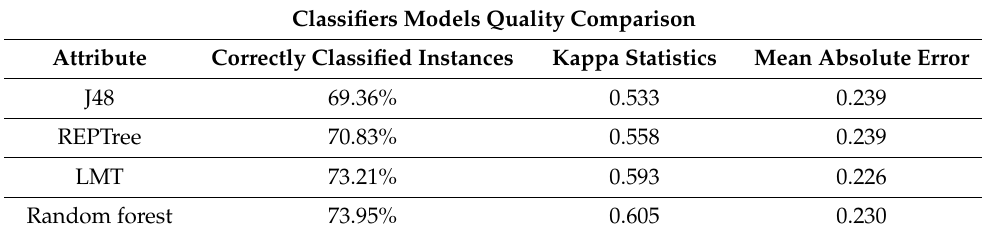
Table 6. Data generated by stratified 10-fold cross